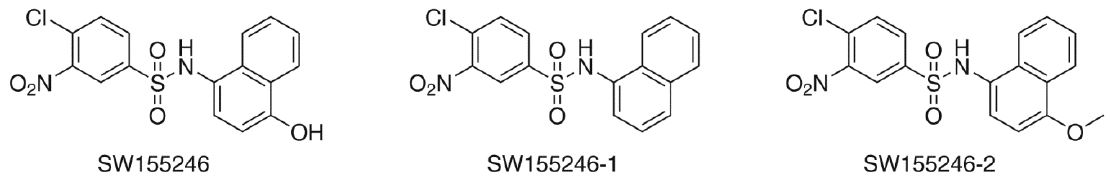
Figure 2. Chemical structures of SW155246 and structural analogues studied in this